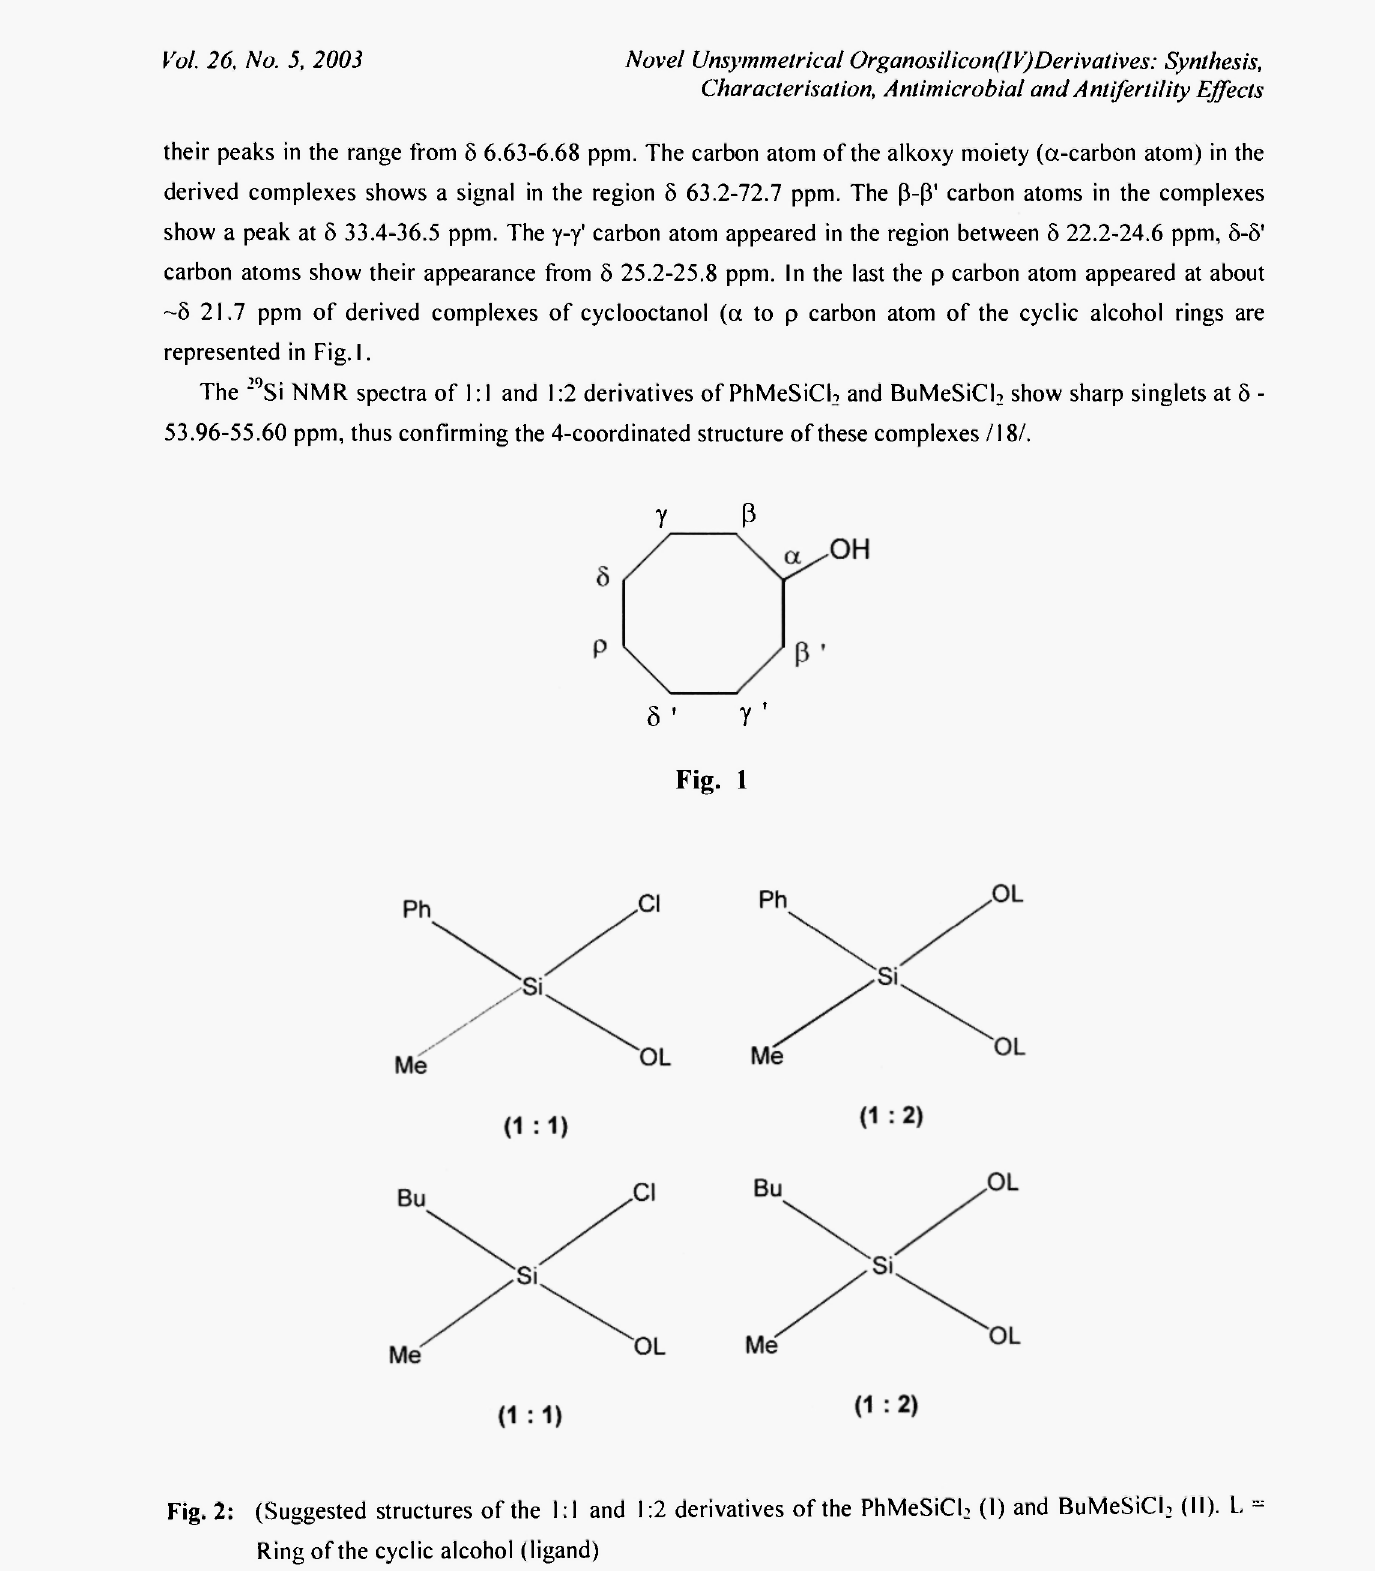
Fig. 2: (Suggested structures of the 1:1 and 1:2 derivatives of the PhMeSiCI 2 (I) and BuMeSiCI : (II). L. = Ring of the cyclic alcohol